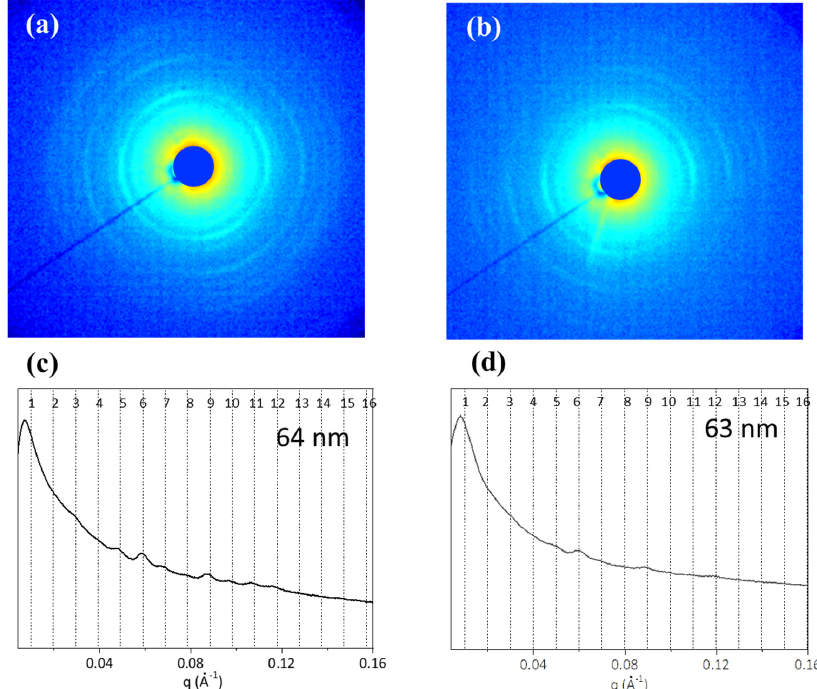
Figure 7. The 2D SAXS patterns of BT ( a ) and ST ( b ) are shown. In the corresponding profiles ( c ) and ( d ), the black dotted lines indicate the fibrillary periodicity.